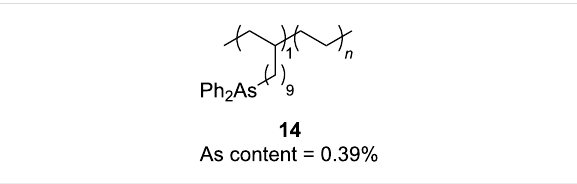
Figure 1: Recyclable polymer-supported arsine for catalytic Wittig-type reactions.